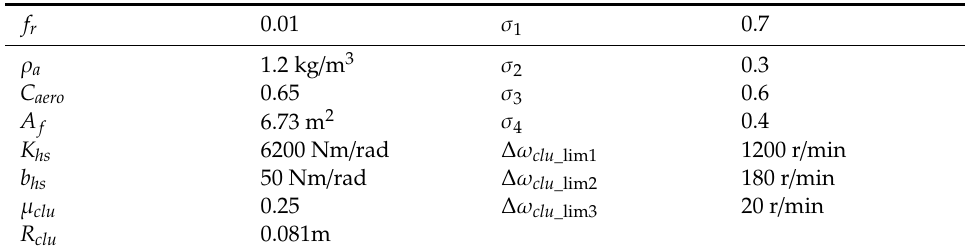
Table A1. Fundamental